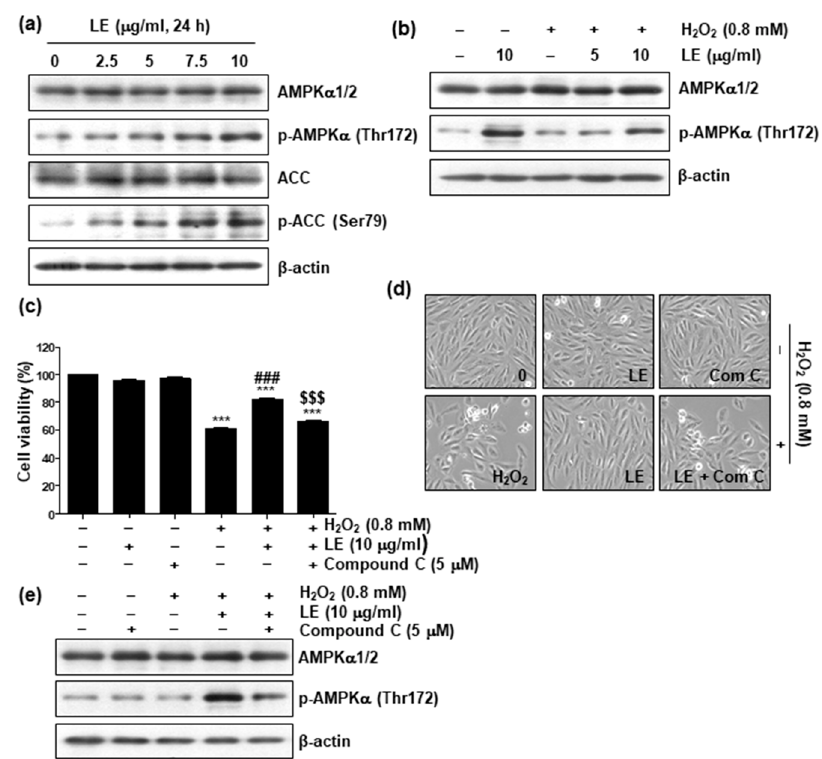
Figure 5. Effect of LE on AMPK signaling in C2C12 cells: ( a ) Effect of LE on the AMPK α 1/2, p-AMPK α (Thr172), ACC, and p-ACC (Ser79) levels of total cell lysates. Western blot analysis was performed using β -actin as a loading control. Representative results from three independent experiments; ( b ) Effect of LE (1 h) and H 2 O 2 (0.8 mM for 24 h) on AMPK α 1/2 and p-AMPK α (Thr172) expression. Western blot analysis was performed using β -actin as a loading control. Representative results from three independent experiments; ( c – e ) Cells were pretreated using 5 μ M compound C, with or without 10 μ g/mL LE, for 1 h and then treated with 0.8 mM H 2 O 2 for 24 h; ( c ) Cell viability was assessed using the MTT assay. Data indicate mean ± SD values ( n = 3; *** p < 0.001 vs. control cells; ### p < 0.001 vs. H 2 O 2 -treated cells; $$$ p < 0.001 vs. H 2 O 2 and LE treated cells); ( d ) Cell morphological changes. Representative results of three independent experiments, which were observed using phase-contrast microscopy, are shown; ( e ) AMPK α 1/2 and p-AMPK α (Thr172) expression. Western blot analysis was performed using β -actin as a loading control. Representative results from three independent experiments are shown. AMPK, AMP-activated protein kinase; ACC, acetyl-CoA carboxylase; Com C, compound C.